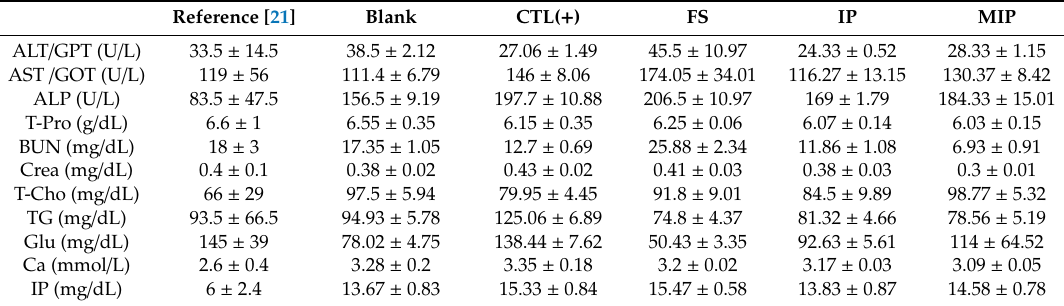
Table 4. Biochemical values of iron supplements in the 14 day repletion in rats.